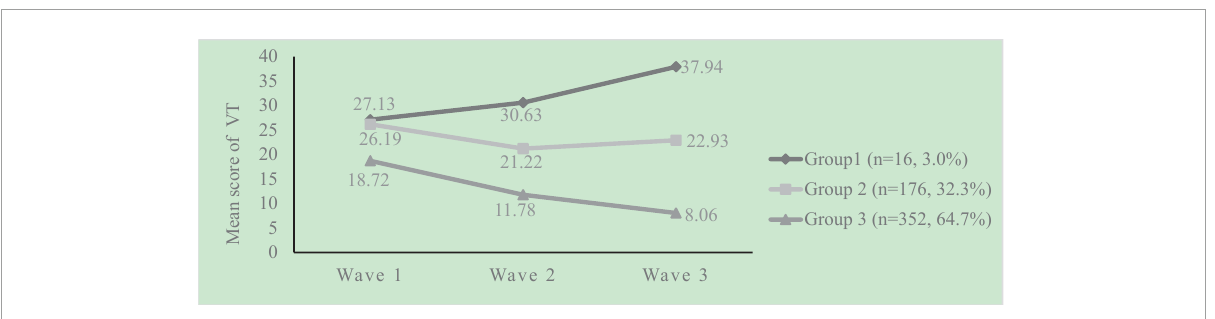
FIGURE4 Trajectories of VT based on the three-class model. Group 1: “medium-level escalating group”; Group 2: “medium-level maintaining group”; Group 3: “low-level descending group.”